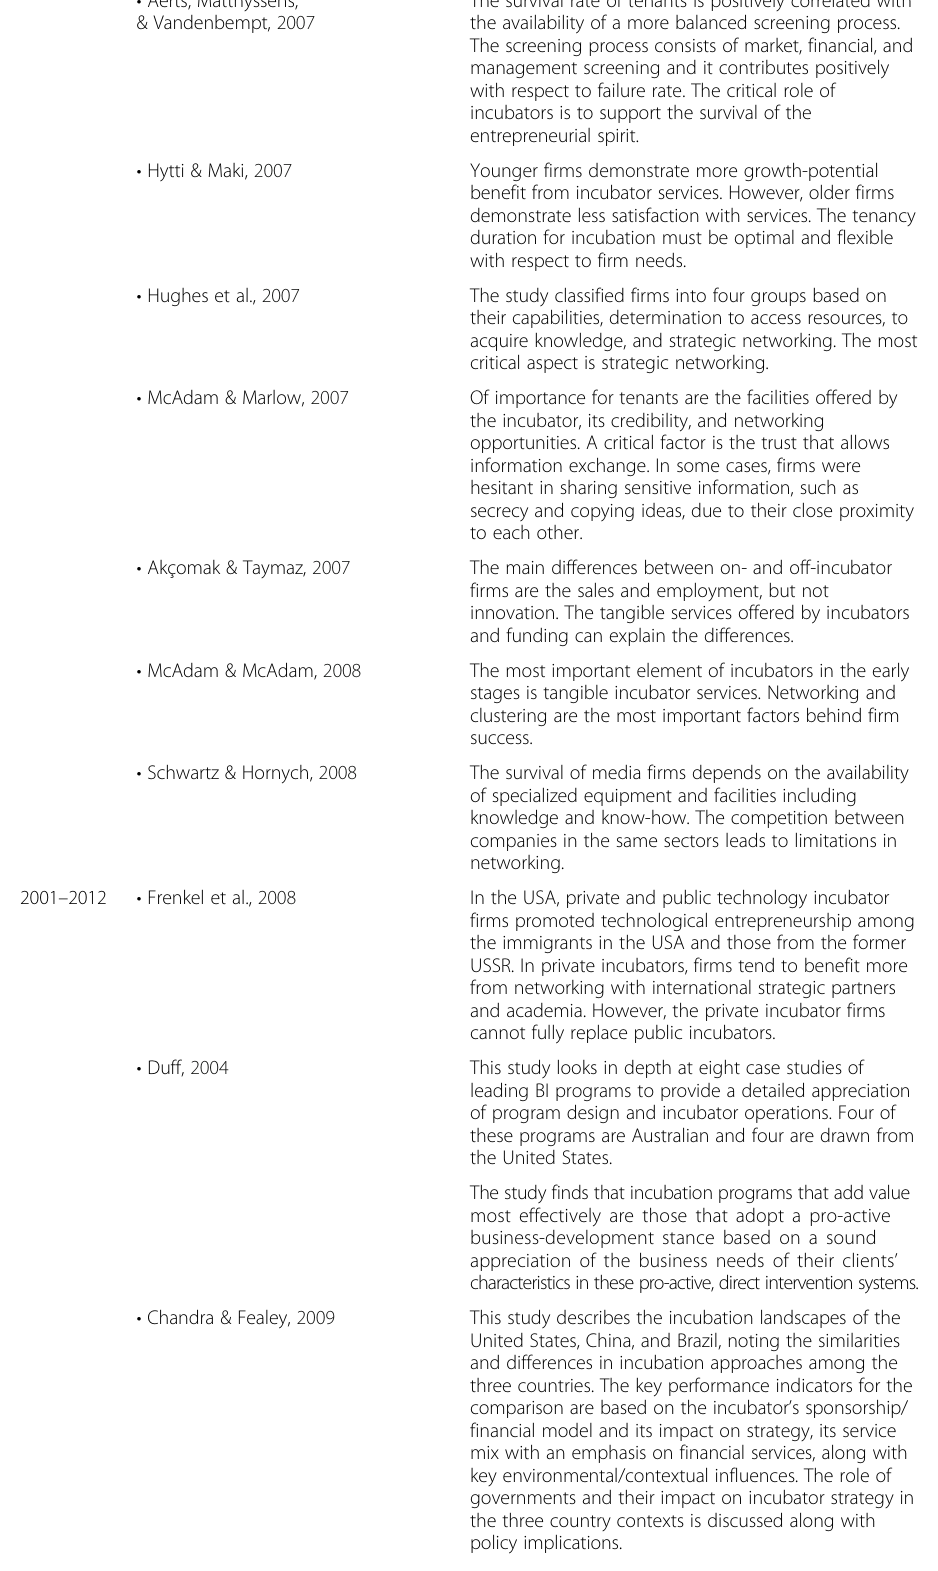
Table 1 Incubators: evidence from the literature